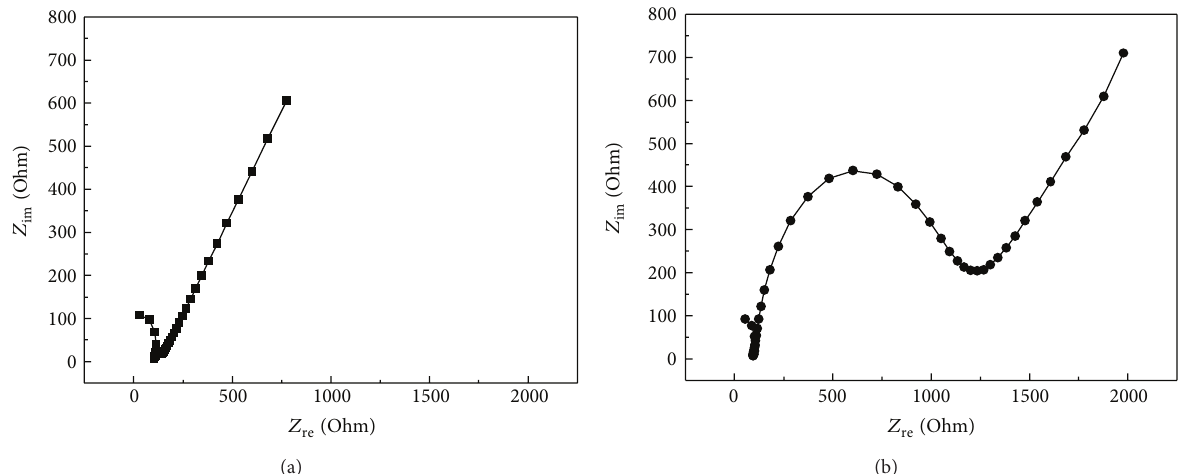
Figure 1: (a) GCE alternating current impedance diagram. (b) PLH/GCE alternating current impedance diagram.